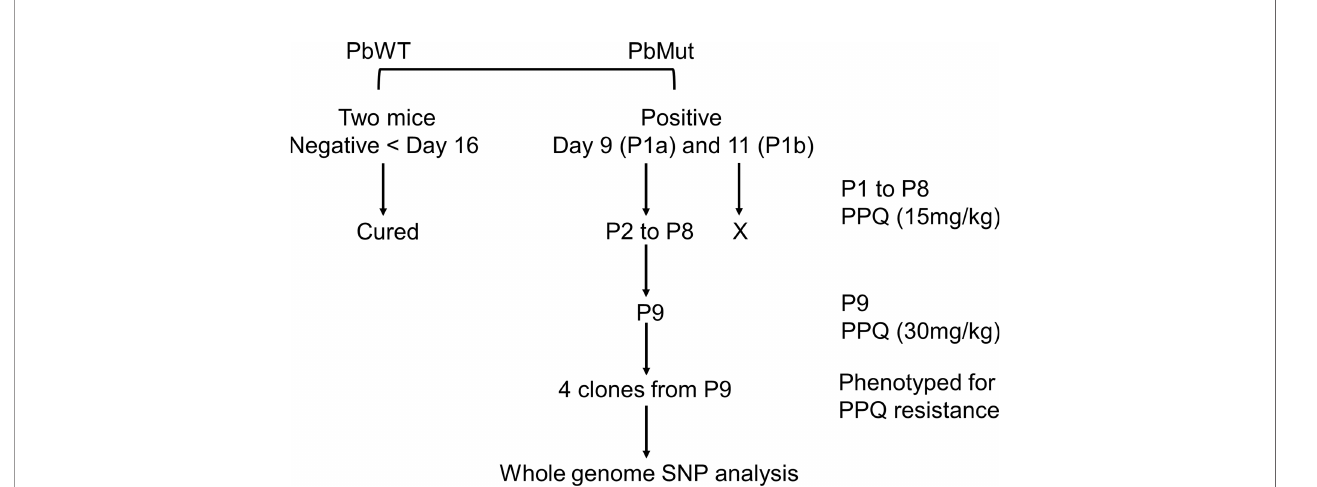
FIGURE 1 | Flow chart of nine-cycle screening for PPQ-resistant parasites. At passage 1 (P1), recrudescence was not con fi rmed in PbWT-infected mice until day 16, while it was detected in both mice infected with PbMut (P1a and b). P1b failed to be passaged to the next mouse (indicated by a cross). P1a proceeded to sequential passages until P9. The four clones from P9 and one clone from the original PbMut (PbMut-P91 clone) were subjected to SNP